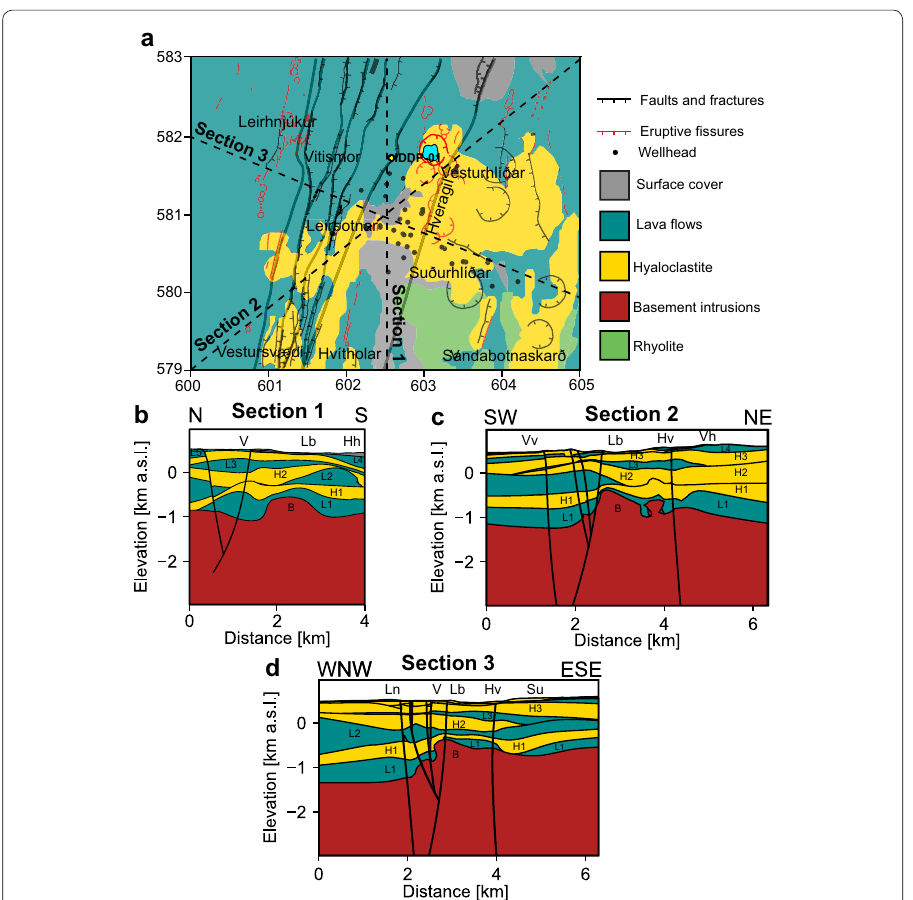
Fig. 3 Reference geologic model of Krafla. a Surface geologic map (Sæmundsson 2008) showing mapped faults and fractures (black), eruptive fissures (red), and drilled wells (black dots). The surface traces of Section 1 (N–S, shown in b ) , Section 2 (SW–NE, c ), and Section 3 (WNW–ESE, d ) shown with dashed lines. Subsurface geology based on Weisenberger et al. (2015), with hyaloclastites (yellow), lava flows (blue-green) and basement intrusions (red). Fault structure is calculated based on surface traces and the assumption of near-vertical dips that lessen with increasing depth, and is highly